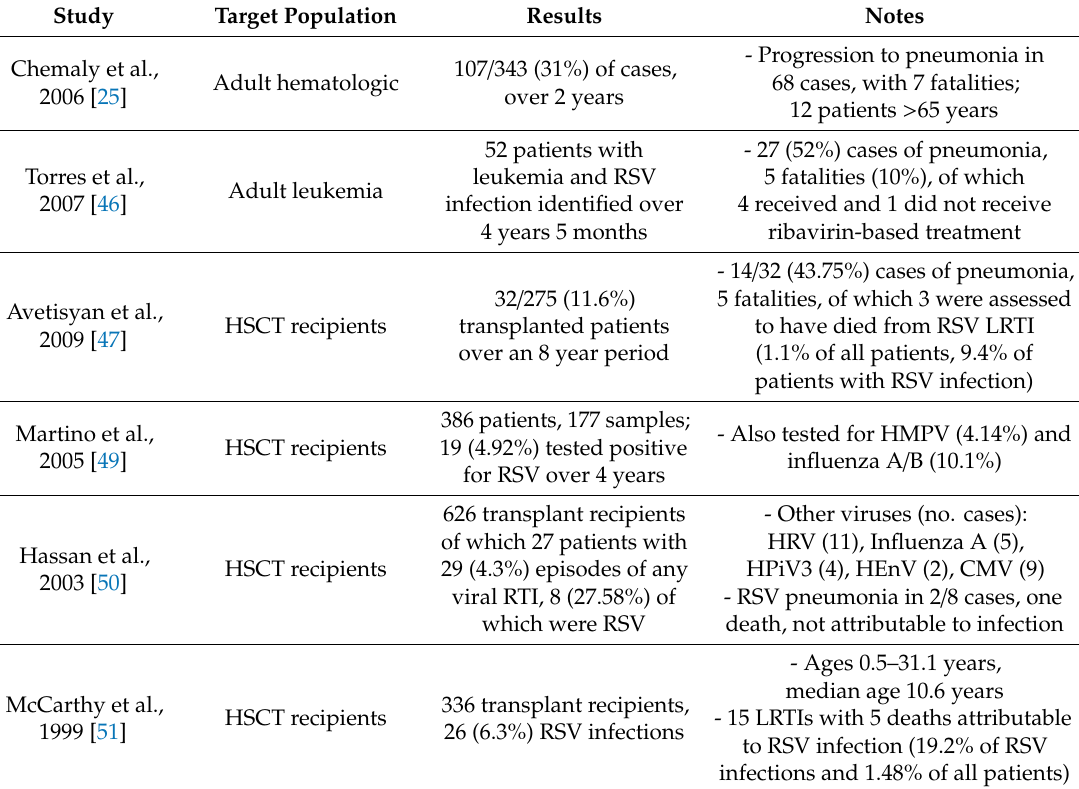
Table 3. Epidemiology of respiratory syncytial virus in hematology